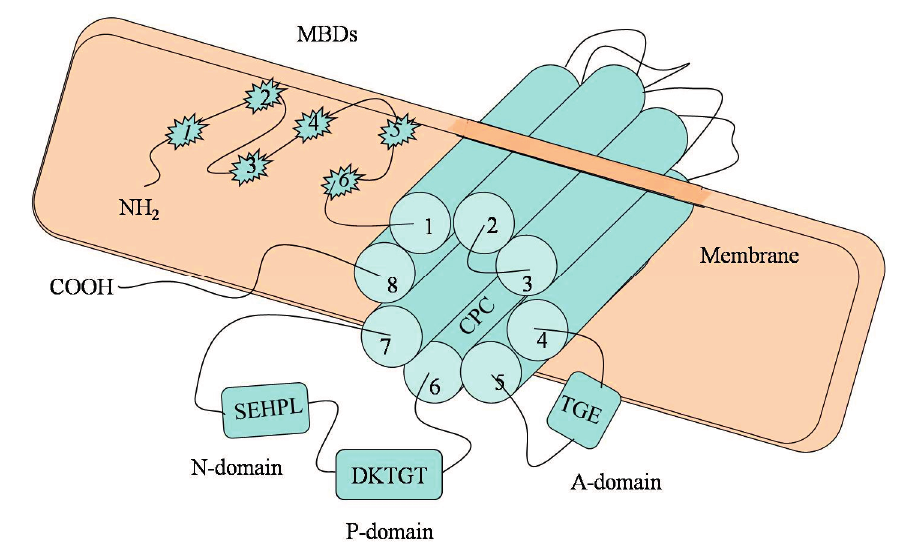
Figure 1. Diagram of ATP7B . The metal-binding domain contains six copper-binding domains (MBD1-6), all with the conserved sequence motif CXXC. The transmembrane channel consisting of eight discontinuous ion channels may contribute to copper transport (Cylinder1-8). The Cys–Pro–Cys (CPC) sequence motif is the key residue that confers metal ion selectively. ATP binds to the N-domain and the SEHPL motif located in the N-domain. The P-domain is the room for phosphorylation of Asp from the sequence DKTGT. The A-domain is the place where the acyl-phosphate gets dephosphorylated. Mutations may occur at any position of the gene, and then may cause the deposition of